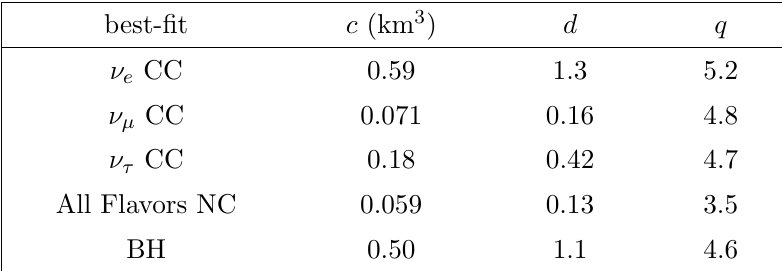
Table 1 . Best-(cid:12)t parameters of M e(cid:11) used in eq. (3.4) for di(cid:11)erent types of interactions in IceCube.